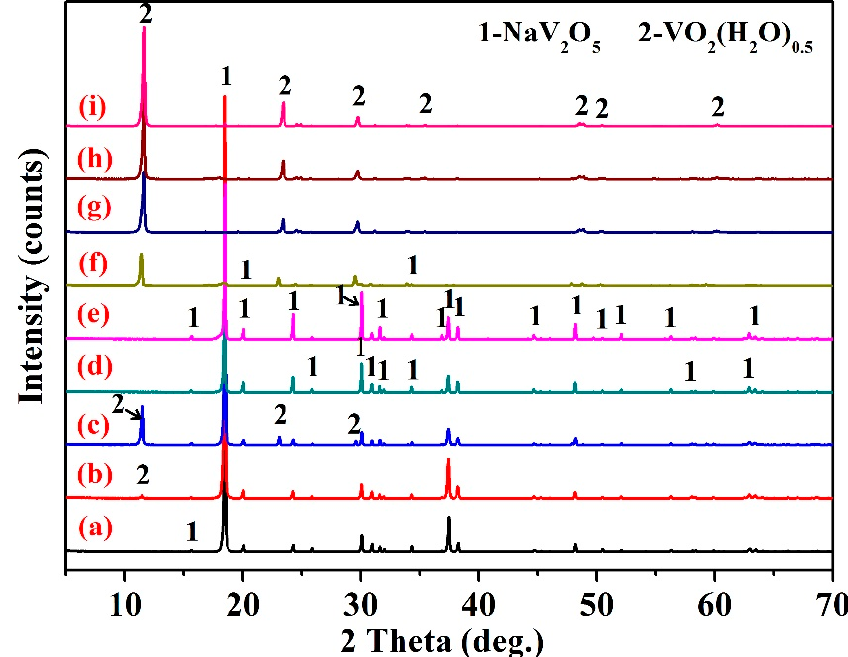
Figure 3. The phase compositions of the products prepared from solutions with different initial pH values of ( a ) 4.0, ( b ) 5.0, ( c ) 6.0, ( d ) 7.0, ( e ) 8.0, ( f ) 9.0, ( g ) 10.0, ( h ) 11.0, and ( i ) 12.0 under a reaction temperature of 200 °C, a H 2 gas partial pressure of 4 MPa, and a reaction time of 2 h.